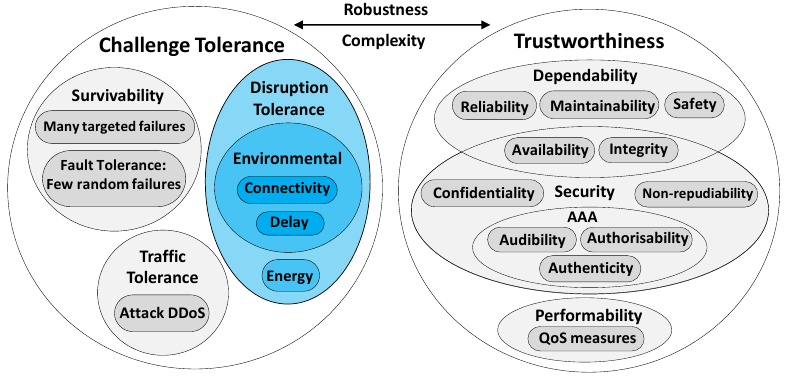
Figure 4. Resilience